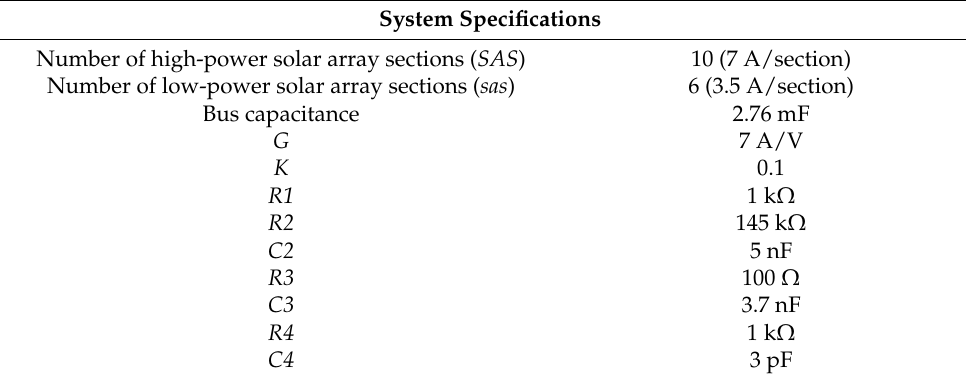
Table 2. Simulated system